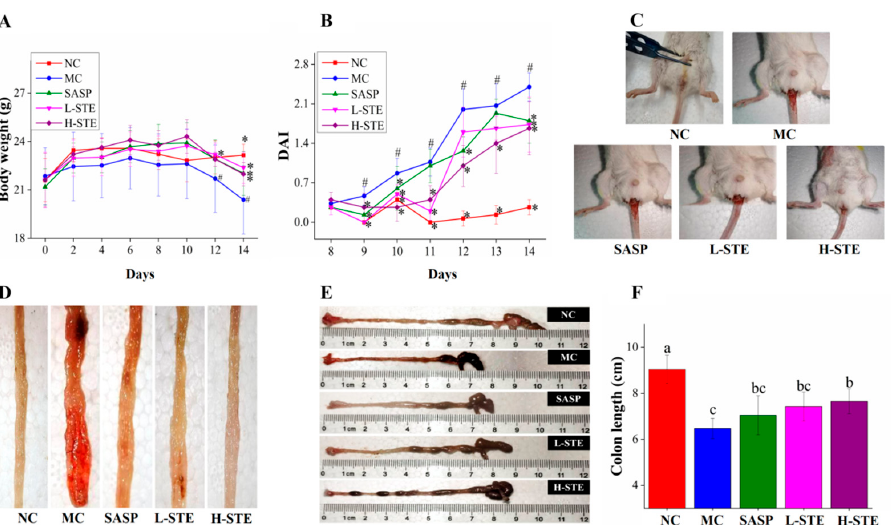
Figure 3. Effects of STE on disease symptoms of DSS-induced ulcerative colitis mice. ( A ) Body weight. ( B ) DAI scores during DSS treatment. ( C ) Typical images of hematochezia. ( D ) Typical images of colonic tissue bleeding. ( E ) Representative images of colon length. ( F ) Colon length. Values are expressed as the mean ± the SD ( n = 10). # p < 0.05 compared to the NC group; * p < 0.05 and ** p < 0.01 compared to the MC group. Bars with different lowercase letters represent significant differences ( p < 0.05).